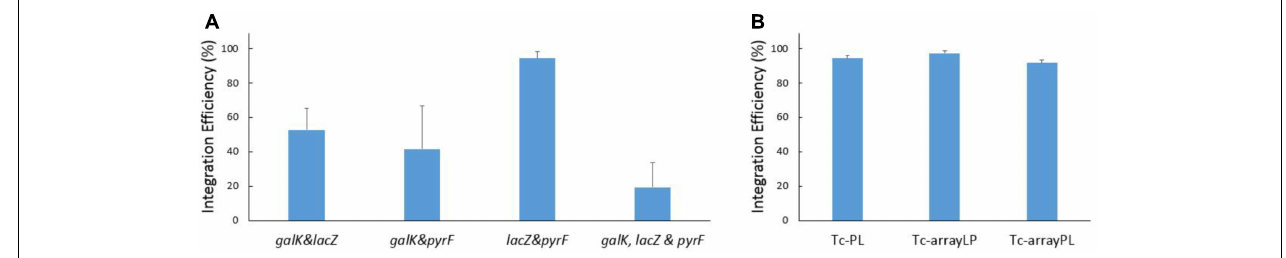
FIGURE 5 | Results of simultaneous recombination at multiple sites. (A) Efficiency of simultaneous integration at two and three sites. The helper plasmid p46Cpf1-OP2 was used. Different combination of two cRNAs against the three selected target sites ( galK , lacZ, and pyrF ) were used in the recombination experiment. The donor plasmids pTc-GL was used for recombination at the galK and lacZ sites; pTc-GP, galK and pyrF sites; pTc-PL, lacZ, and pyrF sites. And the donor plasmid pTc-GLP was used for simultaneous recombination at all the three sites ( galK , lacZ, and pyrF ). (B) Effect of different ways of supplying the crRNAs. The donor plasmid pTc-PL expresses two crRNAs separately, while the donor plasmids pTc-arrayLP and pTc-arrayPL express crRNAs arranged in a CRISPR array. The helper plasmid p46Cpf1-OP2 was used. The data represent the averages of three independent experiments.